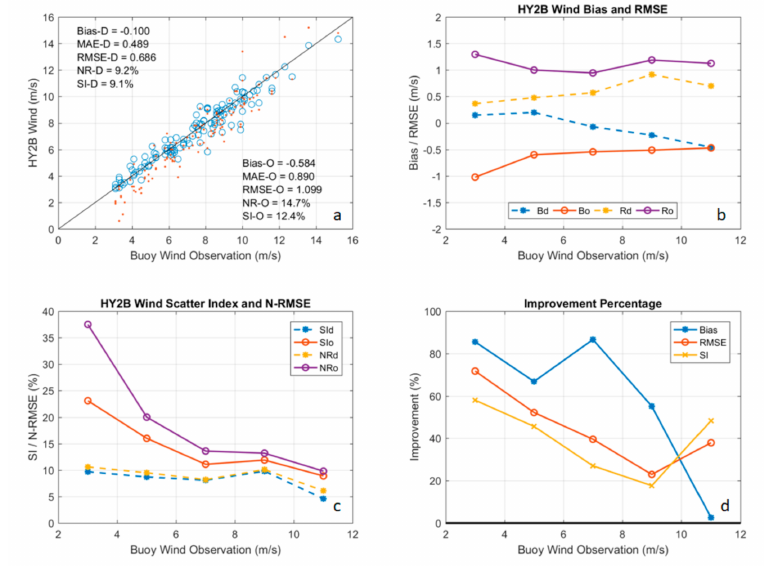
Figure 10. Detailed comparison between the DNN scheme 6 and original HY2B wind speed. ( a ) Shows the scatter plots of original HY2B wind speed (red dots) and DNN-calibrated wind speed (blue cycles); ( b ) shows the bias and RMSE distribution with the wind speed. Bd and Bo represent the bias of DNN calibration and original HY2B, respectively. Rd and Ro stand forRMSE of DNN and original; ( c ) shows the SI and NRMSE variation with wind speed, SId and SIo represent the SI of DNN and original while NRd and NRo represent the NRMSE of DNN and original. ( d ) shows the percentage of improvement by the DNN calibration for bias, RMSE and